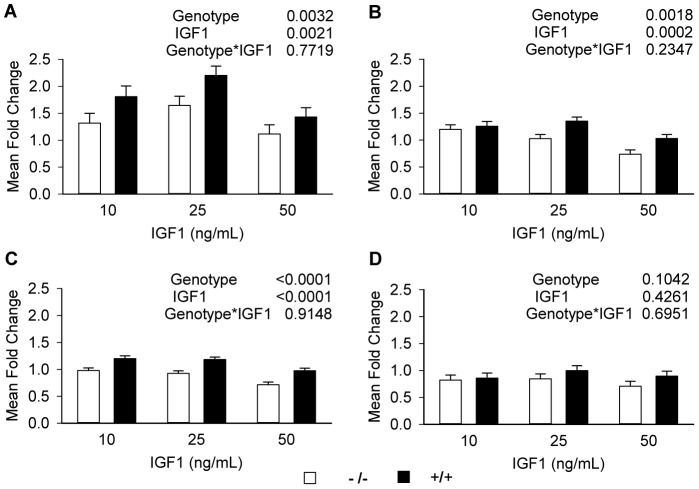
Detection of myosin heavy chain isoform mRNA levels in myotubes by quantitative PCR.Primary myoblasts were isolated from 2 animals for each genotype and two dishes of cells from each animal (4 replicates) were used for each genotype by IGF1 treatment combination. IGF1 was added to the culture 24 hours after differentiation at the indicated concentration. A: Myh4 (Myosin Heavy Chain, Type IIB) expression; B: Myh7 (Myosin Heavy Chain, Type I) expression; C: Myh8 (Myosin Heavy Chain, perinatal) expression; D: Myh3 expression (Myosin Heavy Chain, embryonic). Myh4, Myh7 and Myh8 had significantly higher expression in Park7 (+/+) myotubes, however, no significant differences were detected for Myh3. The mean fold change value was calculated using the 2 –ΔΔCt method with Rplp38 as the control gene and IGF1 concentration of 0 ng/mL as the control treatment.